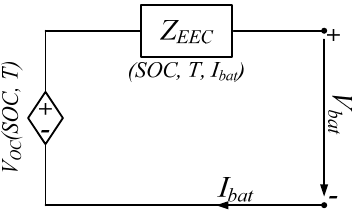
Figure 12. Basic configuration of an EEC-based performance model for Li-ion batteries.